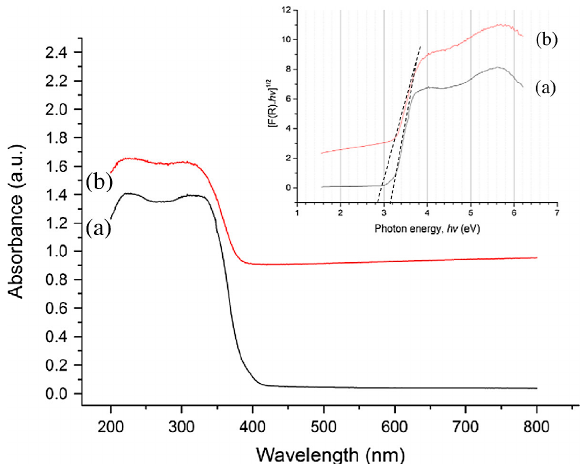
Figure 7. UV–vis di ff use reflectance spectra of ( a ) anatase TiO 2 and ( b ) nanostructured rGO / TiO 2 . Inset: plot of transformed KM function [F(R). hv ] 1 / 2 vs. hv for bandgap determination of anatase TiO 2 and rGO / TiO 2 ; R is reflectance and hv is photon energy. Reproduced with permission from [146]. Copyright Springer, 2013.